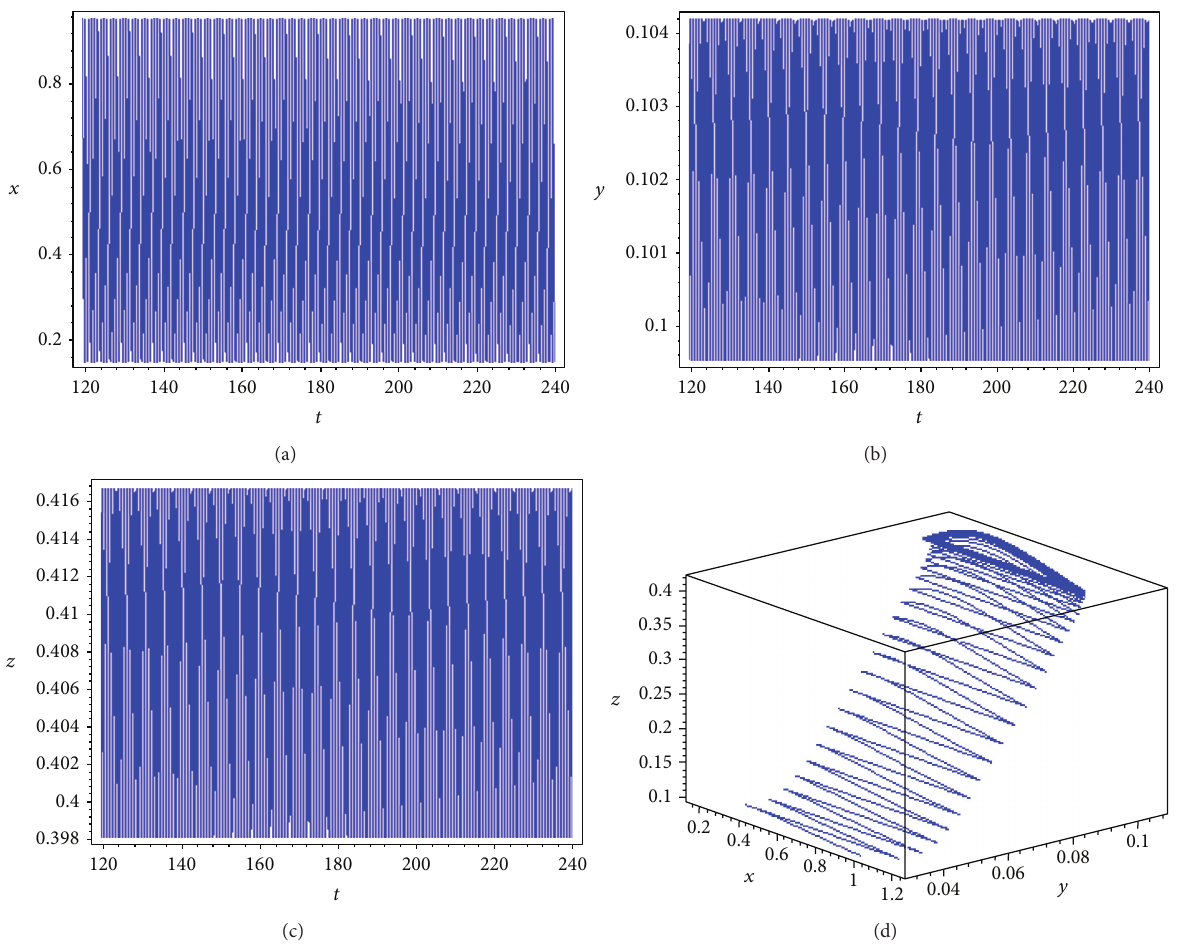
Figure 3: Time series of the system (2) with pulse. 𝑎 1 = 0.2 , 𝑎 2 = 0.2 , 𝑚 1 = 2 , 𝑚 2 = 1.5 , 𝑞 = 0.2 , and 𝑇 = 0.8